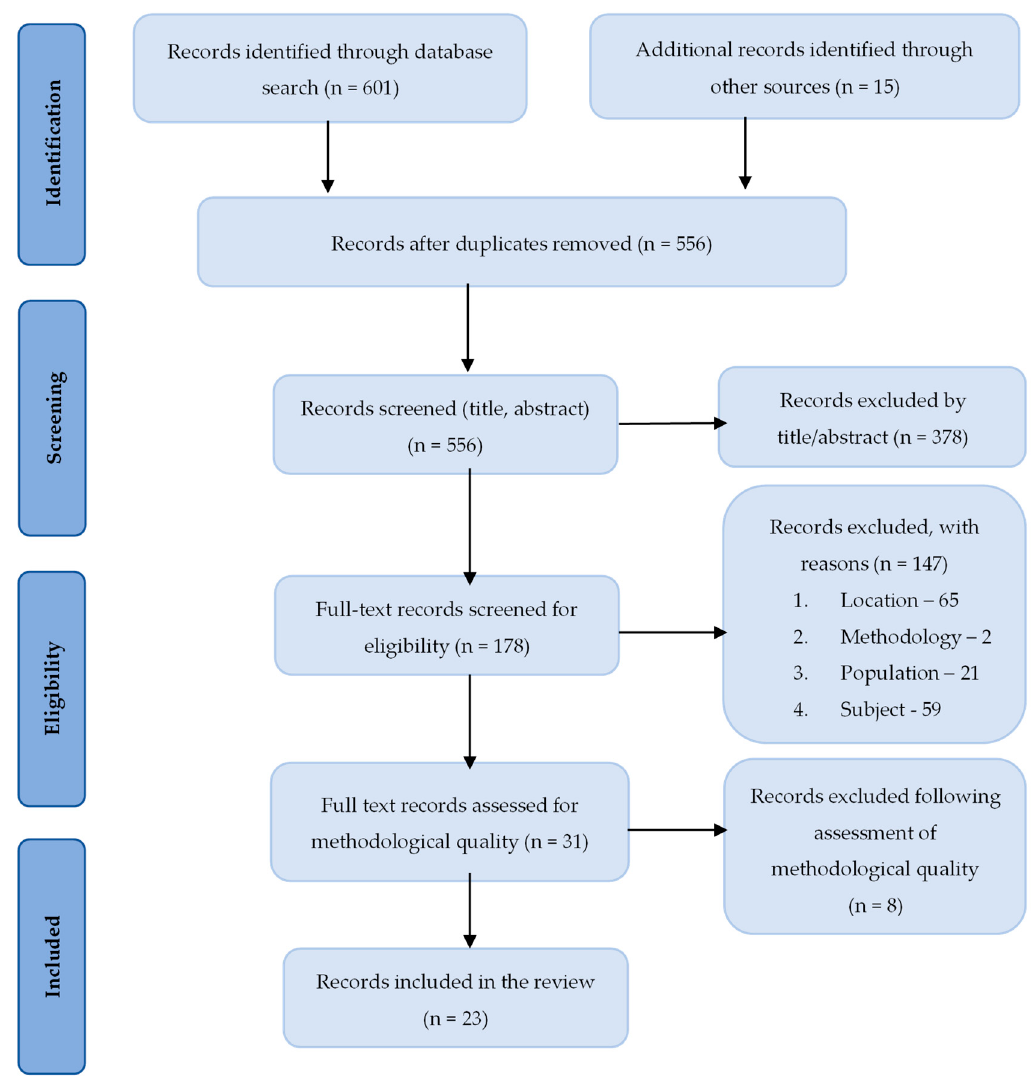
Figure 1. PRISMA Flow Diagram of Search Results, Study Selection and Inclusion Process.